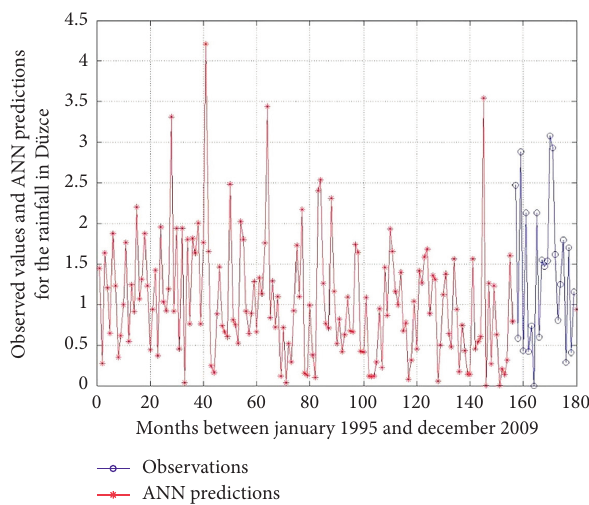
Figure 5: Monthly ANN rainfall predictions for D¨uzce (January 1995 to December 2009).